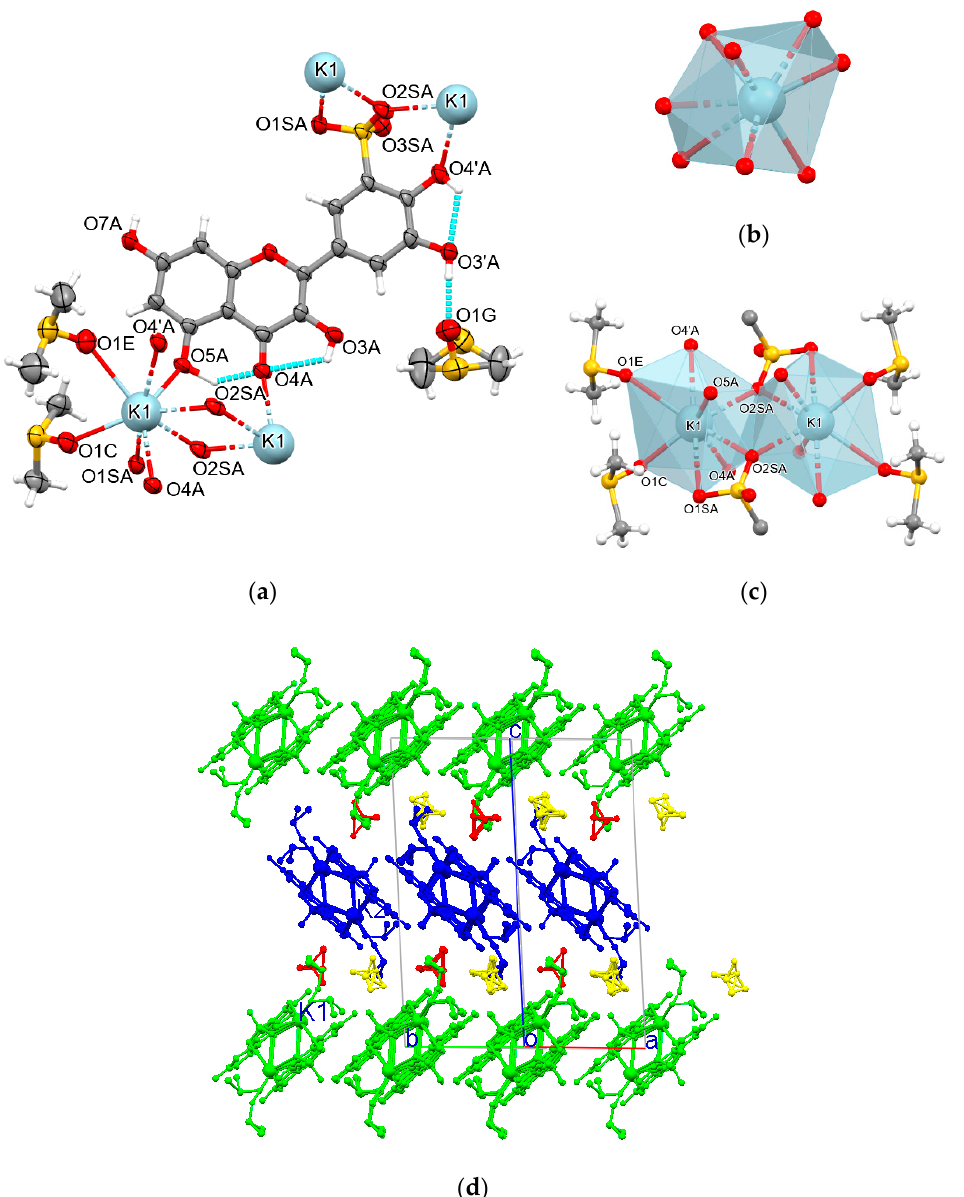
Figure 9. The crystal structure of 3. The structure of the polymeric complexes formed by the cations K(1) and K(2) is analogous, and in this figure only structure involving K(1) is shown. ( a ) The environment of the cation and QSA ¯ anion with DMSO molecules coordinating K + and solvating the crystal network. ( b ) Coordination sphere of K + cation (LK = 8). ( c ) The centrosymmetric K 2 O 14 dimer. ( d ) View of the crystal 3 down the direction [110]. The solvating disordered DMSO molecules are accentuated in yellow and red. The coordination sphere of the K(1) cation is illustrated in green, and that of the K(2) cation in blue. Hydrogen atoms are omitted for